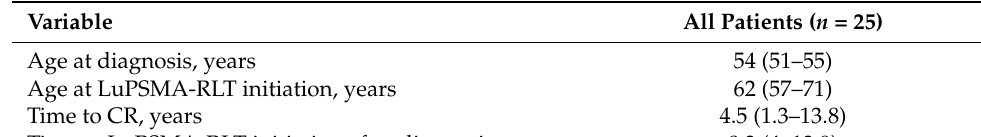
Table 1. Baseline